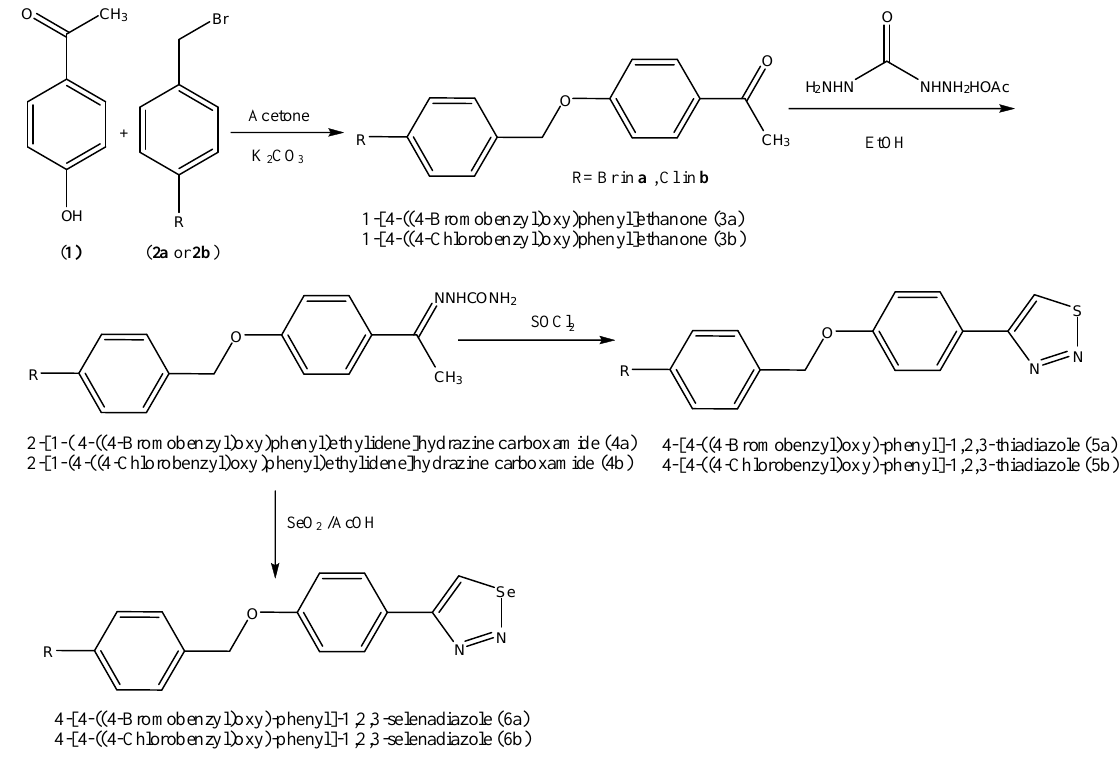
Scheme 1: Synthesis of compounds 3a – 6a and 3b – 6b. Scheme 1. Synthesis of compounds 3a – 6a and 3b – 6b . Table 1. Percentage yields of the synthesized compounds 3a – 6a and 3b – 6b . Table 1. Percentage yields of the synthesized compounds 3a – 6a and 3b – 6b .